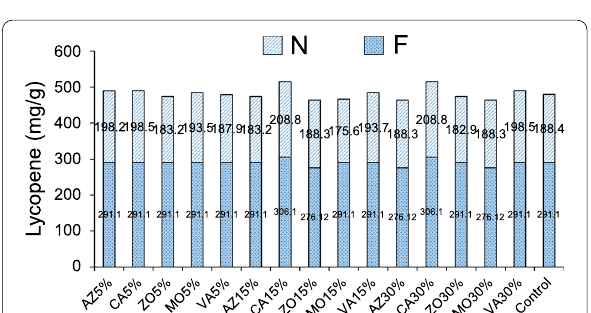
Fig. 2 Lycopene activity in rice plants exposed to the experimental conditions. Keys: N plant innon-ferruginous soil, F plant inferruginous